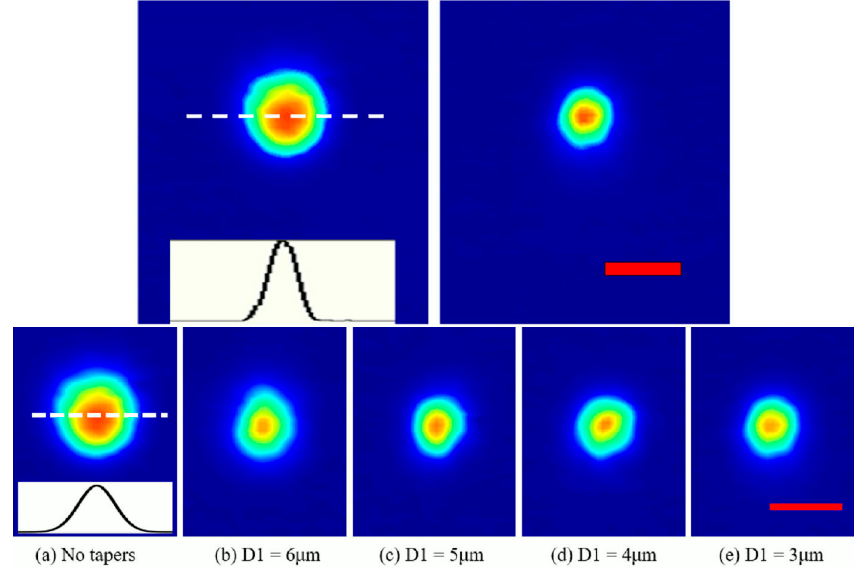
Figure 3. The measured near-field distribution of the waveguides at 785 nm ( a ) without tapers and ( b – e ) withthe tapered structures of different D1 at the output facet of the substrate (the inset in ( a ) shows the typical intensity profile at the peak for MFD measurement, scale bar: 10 μ m).